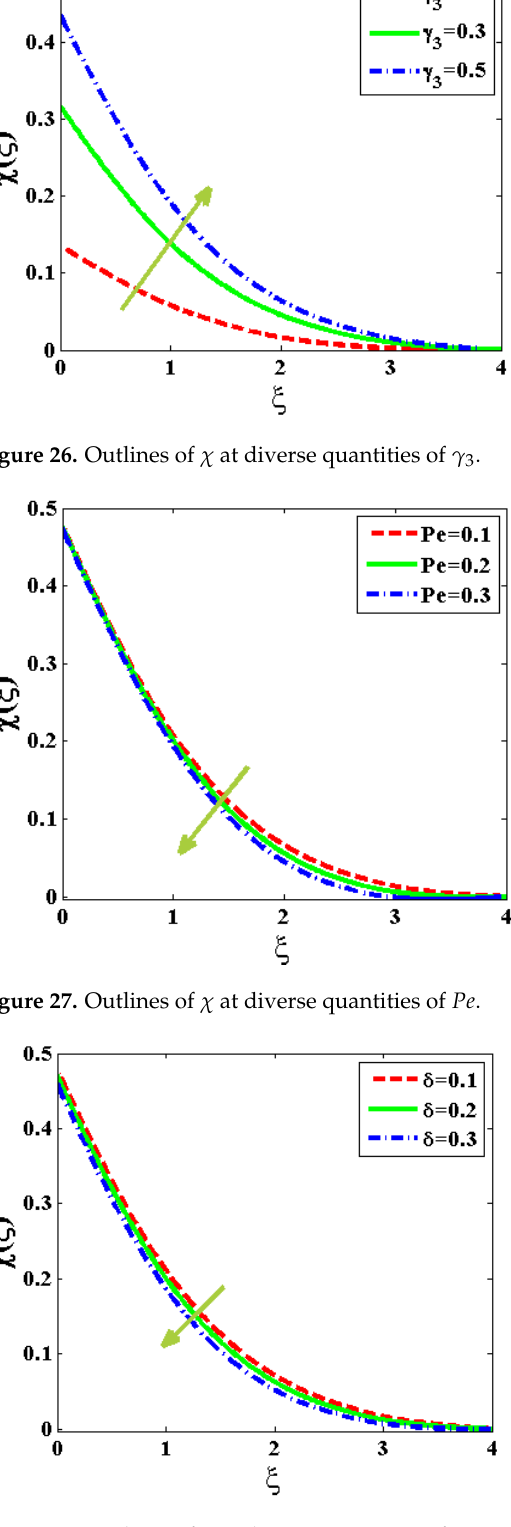
Figure 28. Outlines of 𝜒 at diverse quantities of 𝛿 .